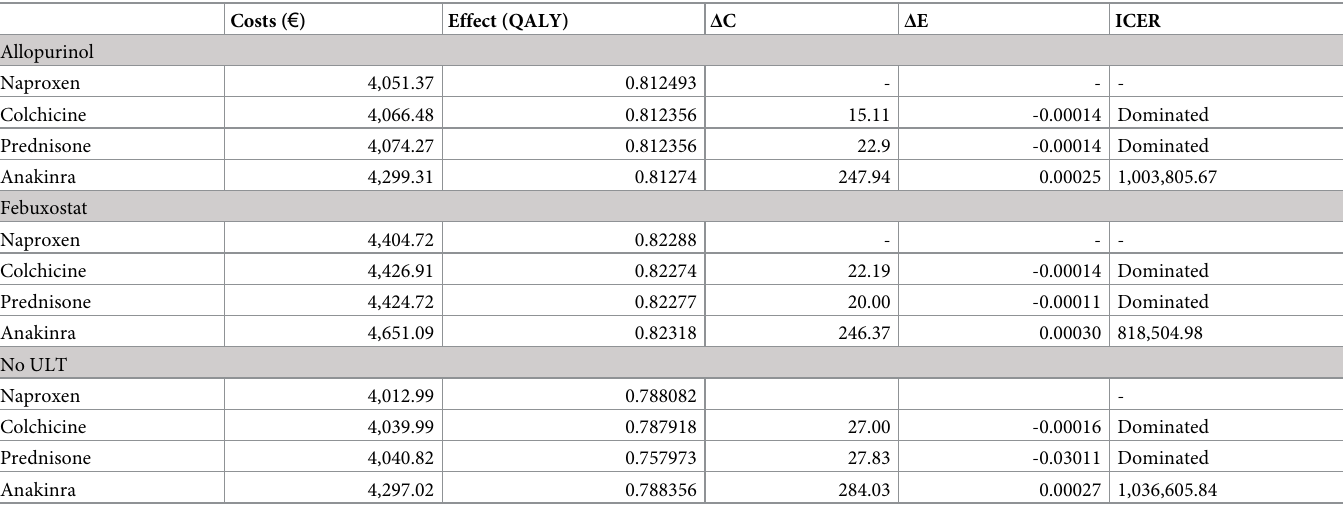
Table 3. Probabilistic sensitivity analysis for anti-inflammatory